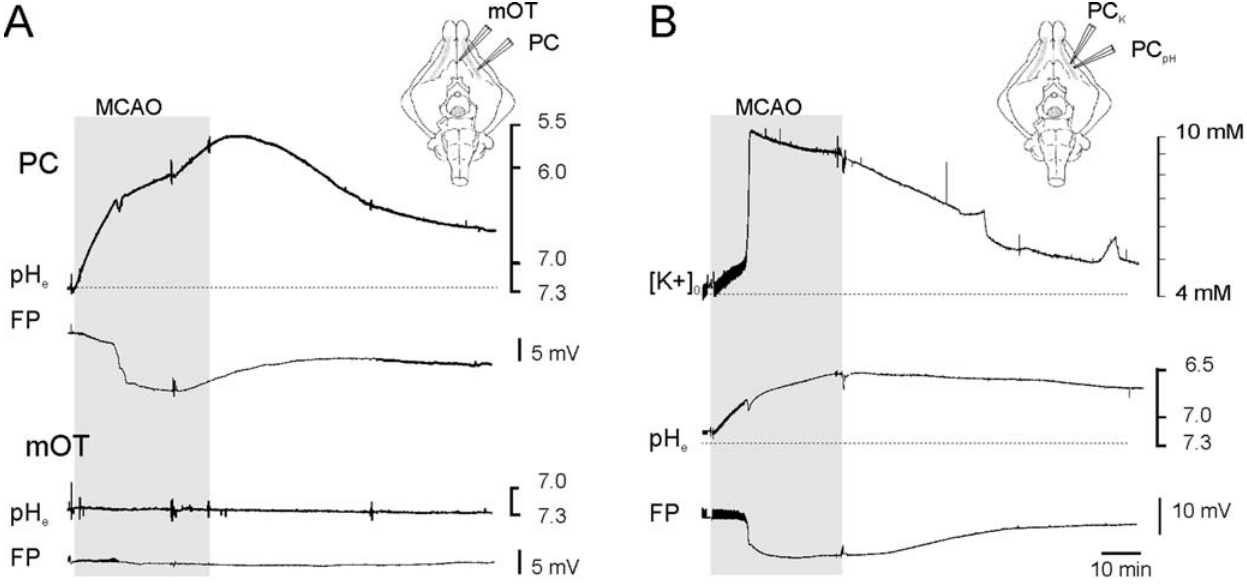
Figure 4. (A) Changes in extracellular pH (pH e ) in the PC and in mOT induced by ipsilateral MCA occlusion and reperfusion. Occlusion induced a rapid metabolic acidification of the extracellular microenviroment in PC, interrupted by a transient and mild basification (arrow) associated to the hypoxic spreading depression (HD, asterisk). No changes in extracellular [H + ] were recorded in the mOT, that is not served by the MCA. (B) Simultaneous changes in extracellular potassium concentration ([K + ] o )and extracellular pH in the PC after MCA occlusion and reperfusion. An initial enhancement in [K + ] was followed by a fast and large increase in [K + ] o . associated to the HD. The schematic drawing on the right illustrates the position of the two-barrel recording electrodes. The field responses (FP) recorded with the conventional extracellular barrel are also shown. The period of MCA occlusion is marked by the shaded area.